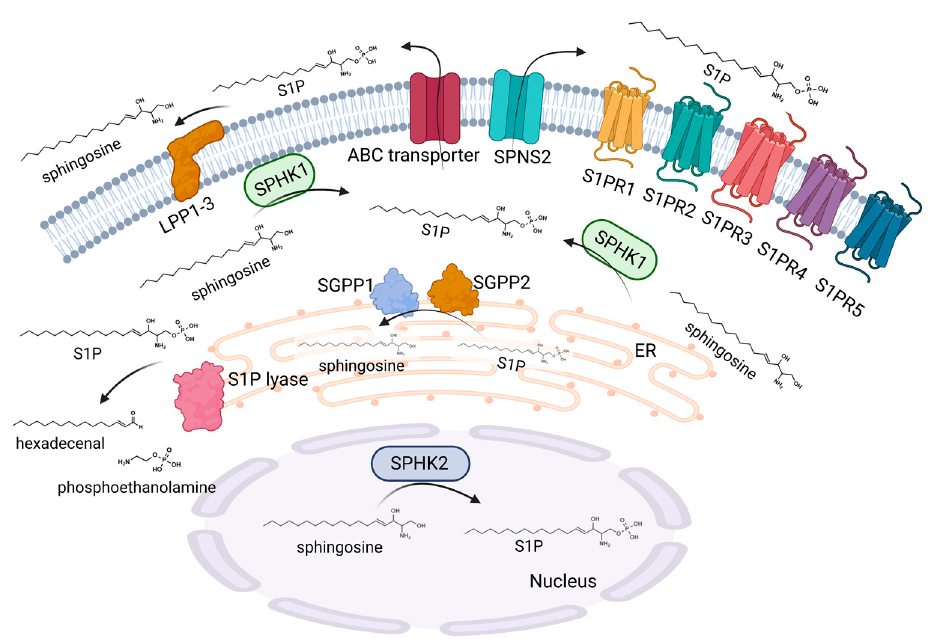
Figure 3. S1P metabolism and signaling. S1P is synthesized via SPHK1 and SPHK2. SPHK2 is mainly located in the nucleus, whereas SPHK1 is present in the cytoplasm. SPHK1 can translocate to the plasma membrane after stimulation, which facilitates the secretion of S1P into the extracellular environment. SPNS2 and several ABC transporters have been identified as transporters of S1P through the cell membrane. Extracellular S1P can act via five G-protein coupled receptors, namely S1PR1-5. The degradation of extracellular S1P occurs via three lipid phosphate phosphatases, LPP1- 3. Intracellular S1P is metabolized by two phosphatases, SGPP1 and 2, which are located at the endoplasmic reticulum membrane with the active site on the luminal side. An irreversible degradation of S1P is catalyzed by the S1P lyase, which is also present in the endoplasmic reticulum with the active site on the cytosolic side, leading to the formation of hexadecenal and phosphoethanolamine. Created with BioRender.com.